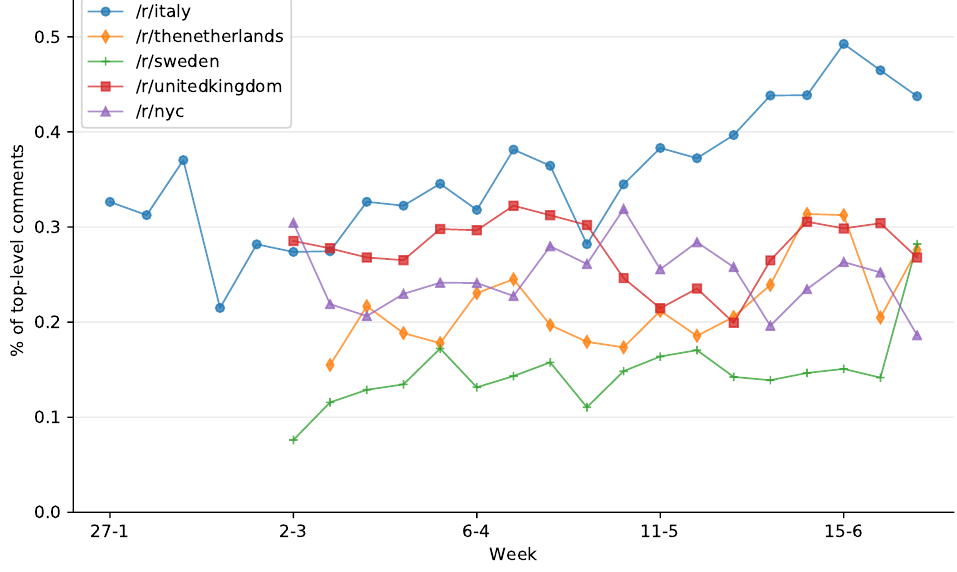
Figure 21. Timeline of skepticism expression rate during